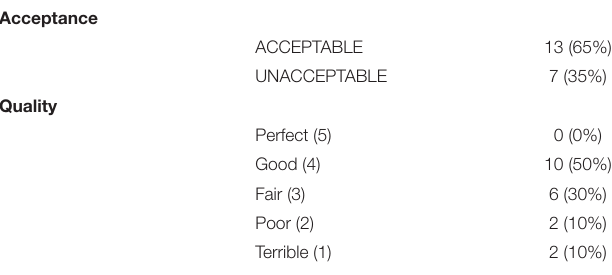
TABLE 2 | Results of reference dataset of 20 MR scans at initial release of EASE.